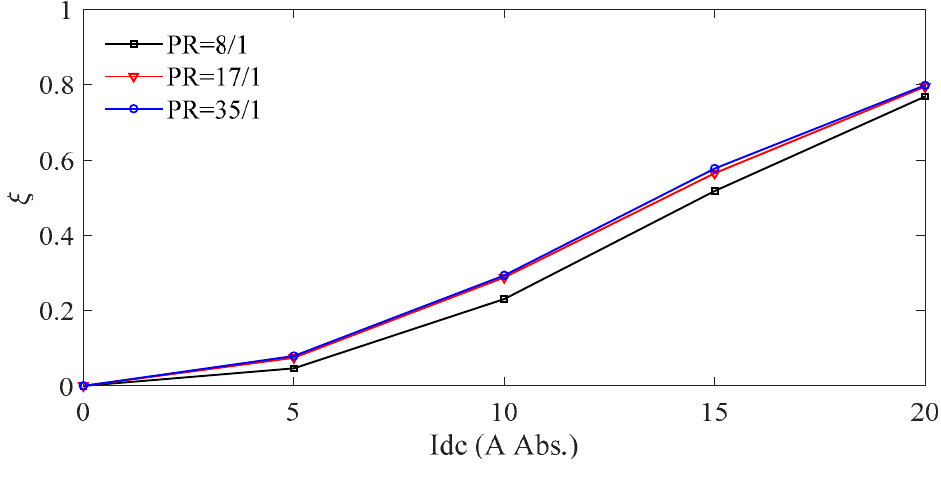
Figure 6. Flux-weakening path in stator split-teeth.